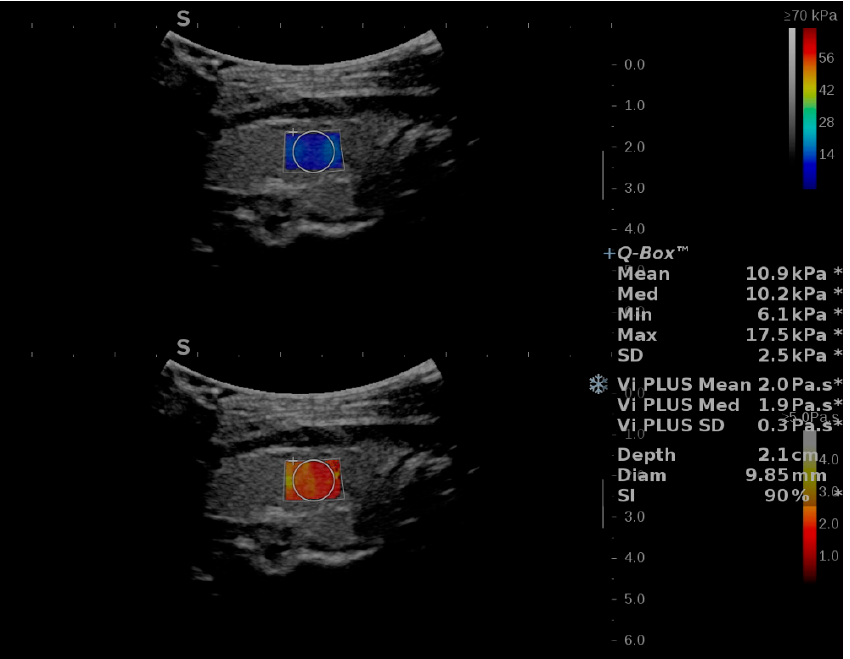
Figure 1. Illustration of two-dimensional Shear-Wave Elastography PLUS (2D-SWE.PLUS) and viscosity PLUS (Vi.PLUS) measurements in a subject without thyroid pathology. Two colored maps